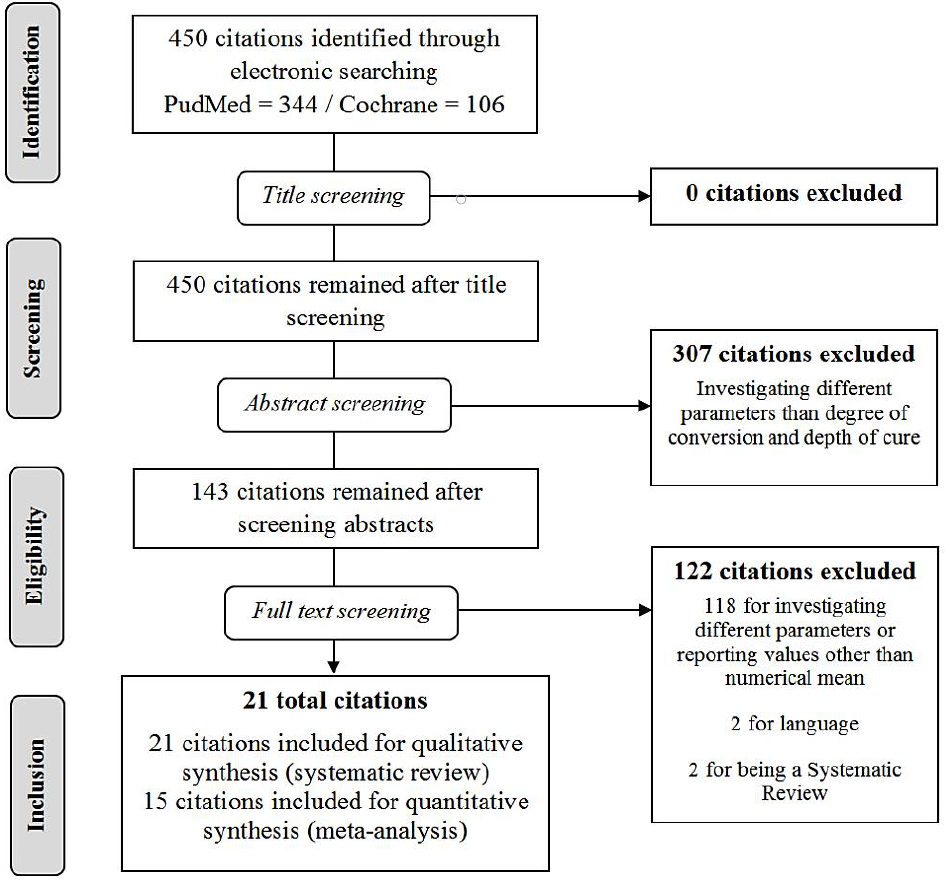
Figure 1. A PRISMA flow chart illustrating the identification process of the included studies in the systematic review and meta-analysis.